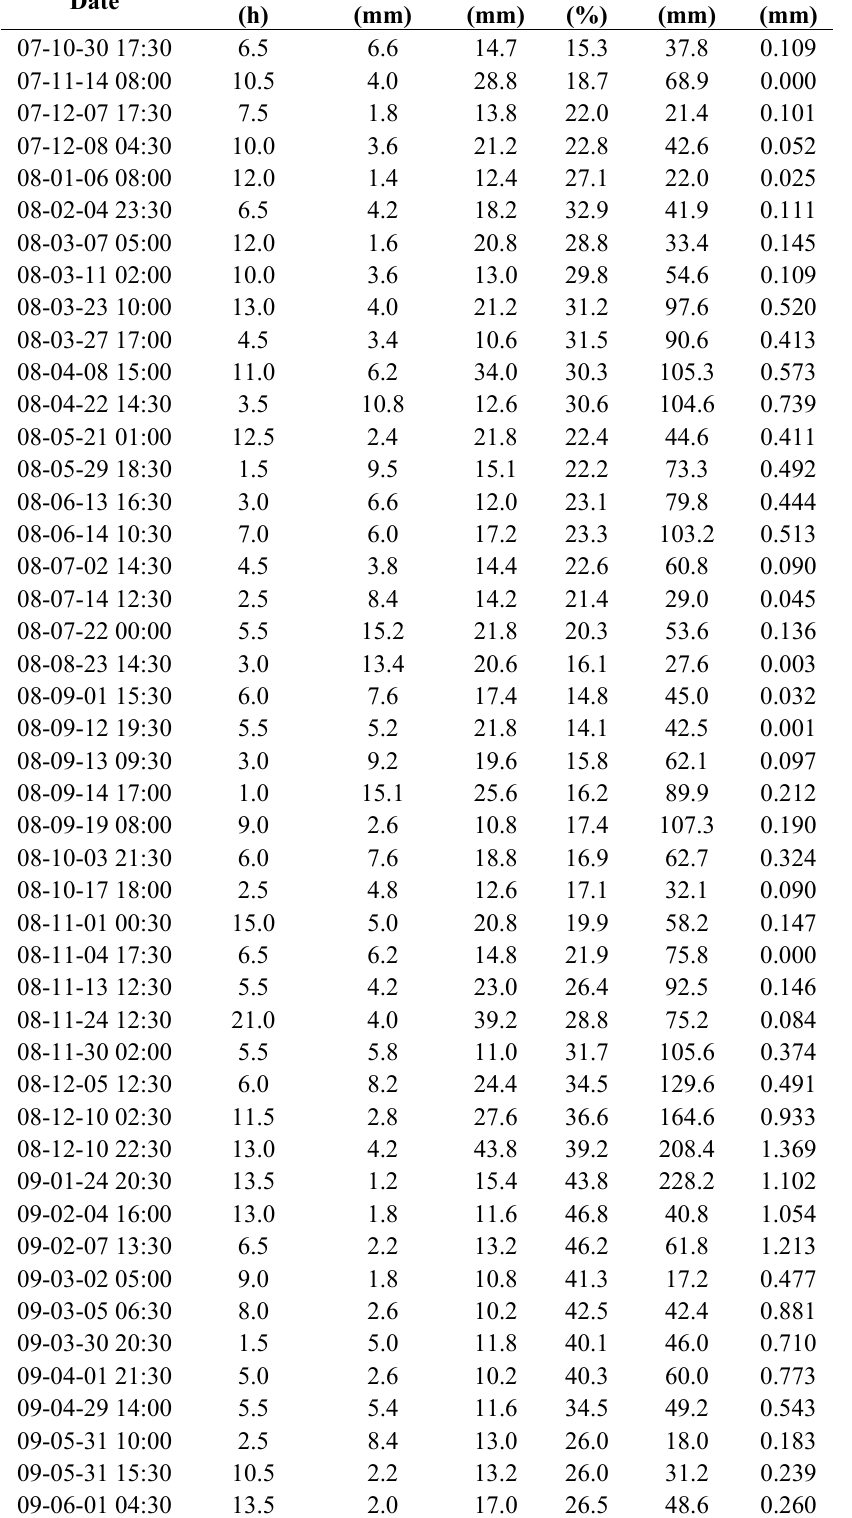
Table 1. Main characteristics of the selected rainfall events with the best predictors used in the multiple regression analysis ( P : maximum rainfall over a duration of 1 hour, P max-1h total rainfall, SWI : ASCAT Soil Water Index with T = 75 days, API 75 Precipitation Index with N = 20 days, dH : crack